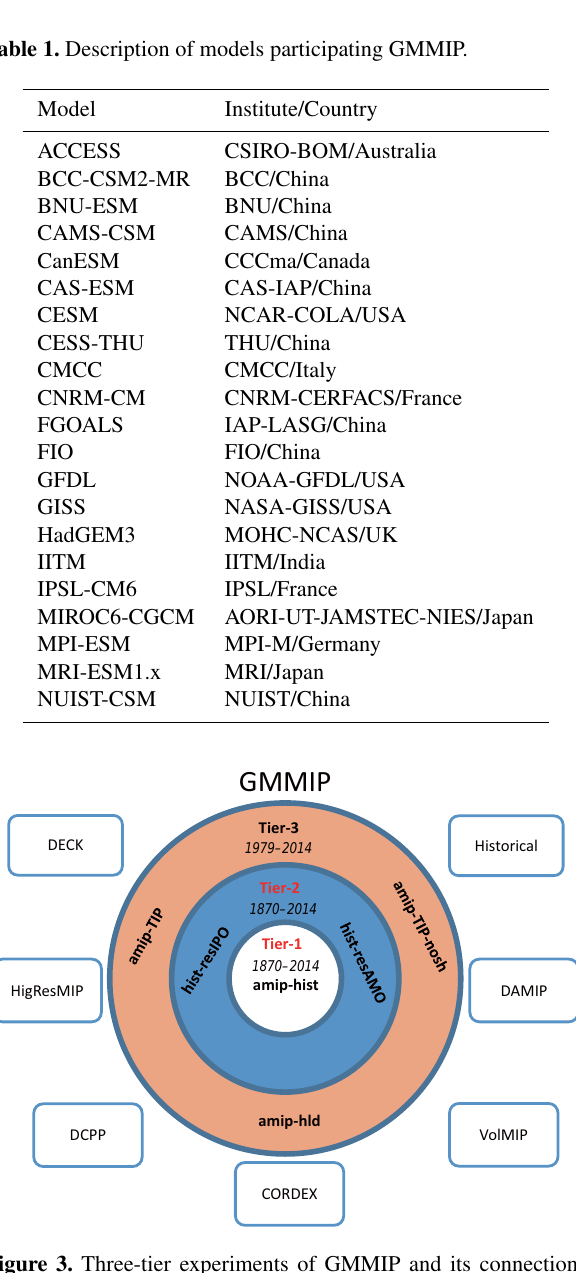
Figure 3. Three-tier experiments of GMMIP and its connections with DECK, historical simulation and endorsed